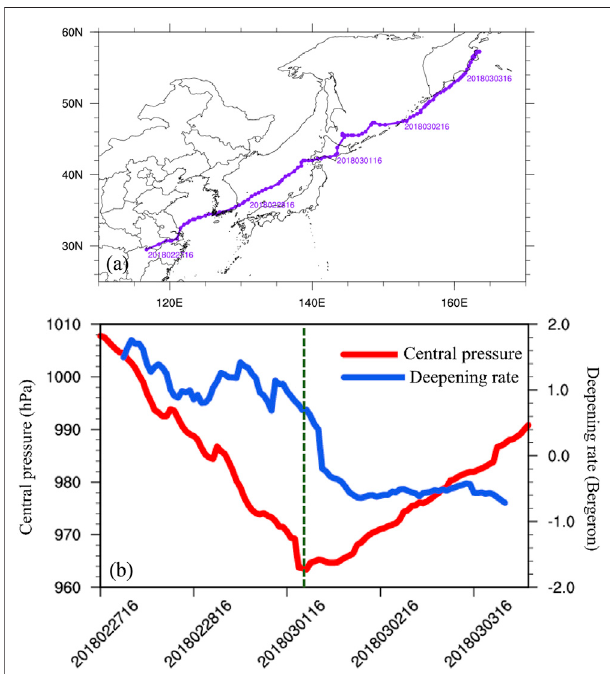
FIGURE 1| (A) The track of the explosive cyclone (purple line with dots), where the dots show the location of the cyclone ’ s center. (B) The central pressure of the cyclone (thick red solid line; hPa) and its deepening rate (thick blue solid line; Bergeron), where the green dashed line shows the time when the cyclone reached minimum central